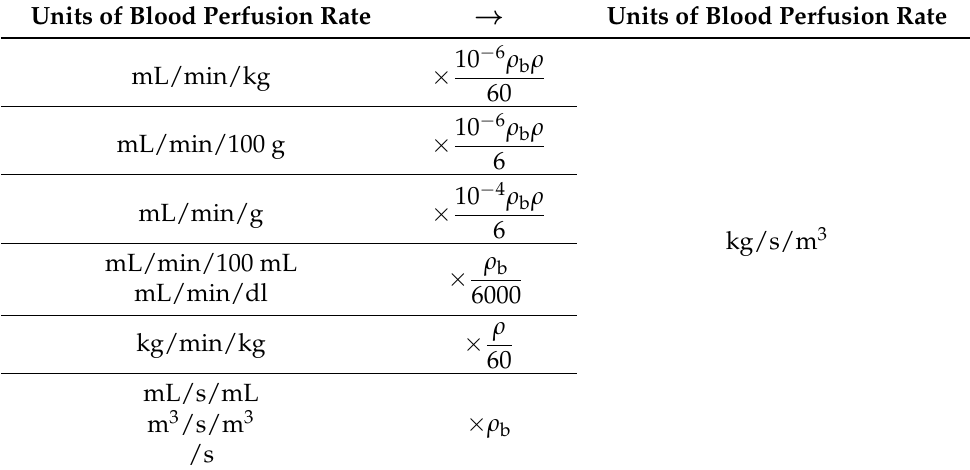
Table 1. Conversion table for units of blood perfusion